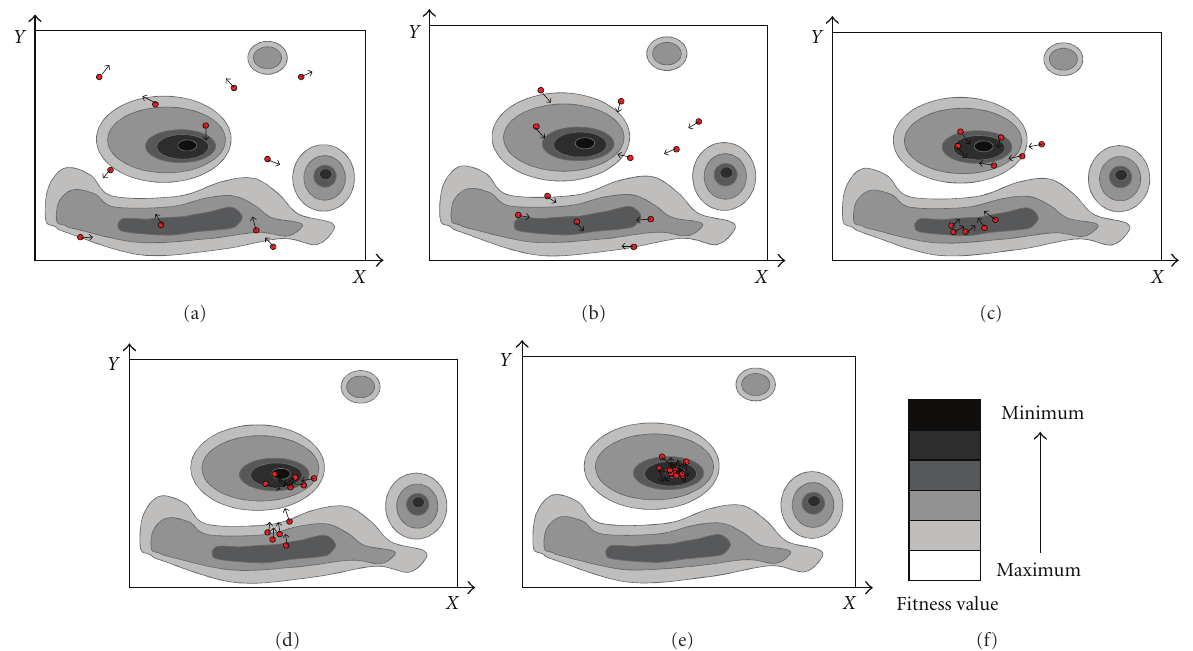
Figure 2: Trajectory of particles in the search space at various iterations in order (a–e) while moving towards the global minima, and (f) indicates the values of fitness function at various locations in the search